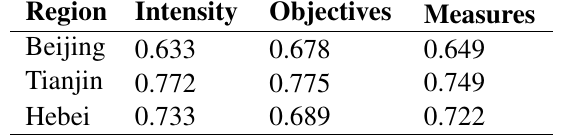
Table 9 GRA analysis result of government guidance fund policy and policy output Region Intensity